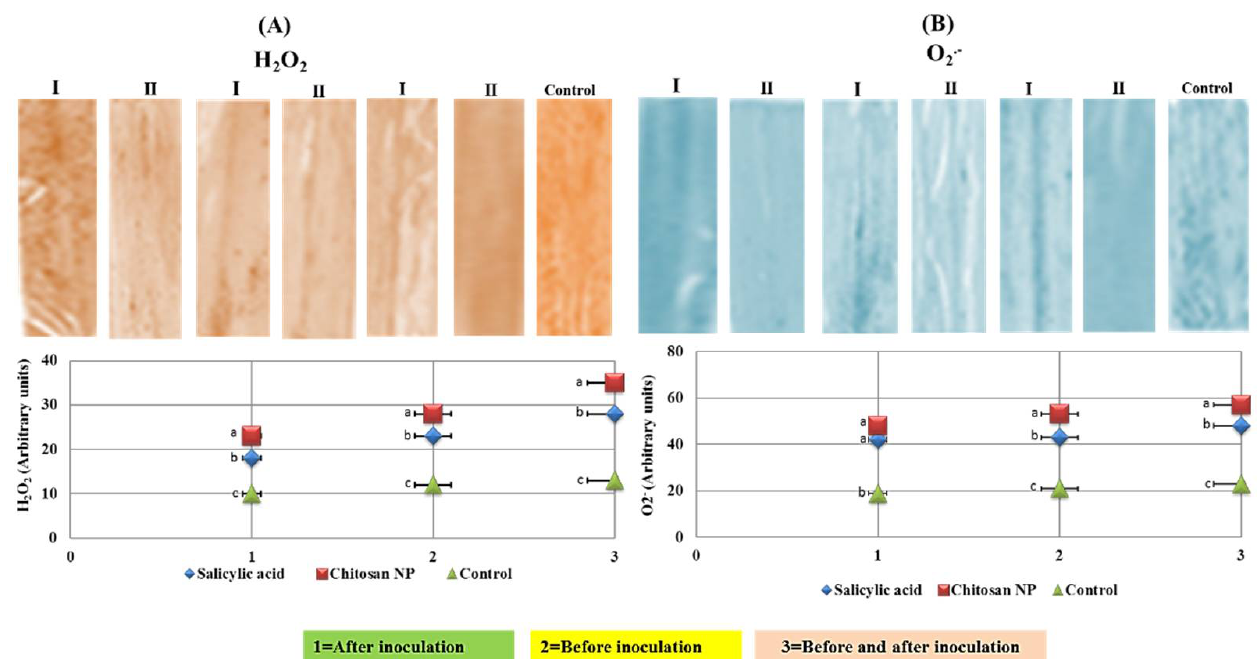
Figure 7. Effect of salicylic acid (I) and chitosan nanoparticles (II) on hydrogen peroxide ( A ) and superoxide anion ( B ) in infected plants with Puccinia triticina with three application methods (1 = spray before inoculation by 24 h, 2 = spray after inoculation by 24 h and 3 = spray before and after inoculation by 24 h). The letters (a, b and c) denote significant difference.